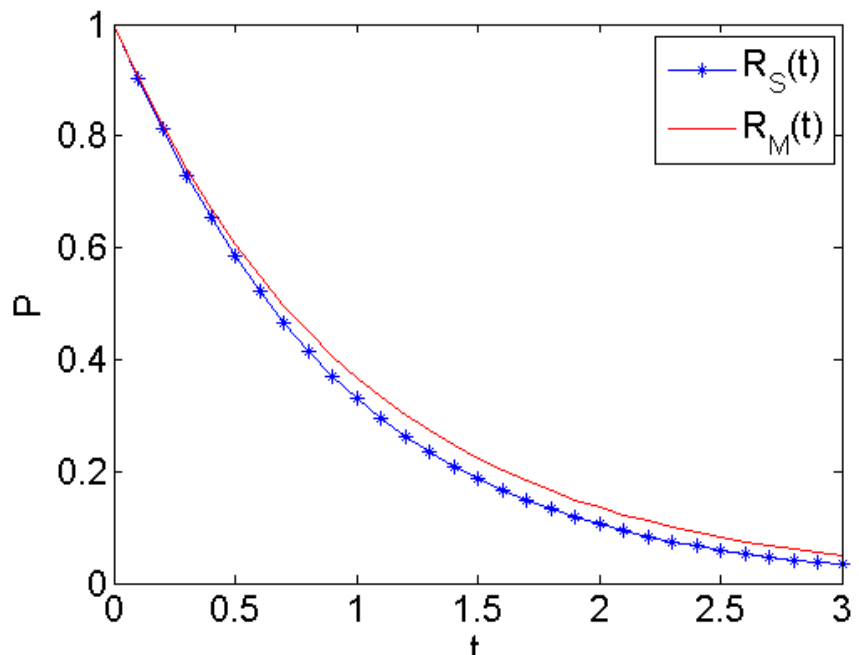
Figure 4. The transient-state reliability functions of the machine ( R M ( t )) and the server ( R S ( t )) for λ = 1, µ = 2, ξ 1 = 1 and ξ 2 = 1.5.